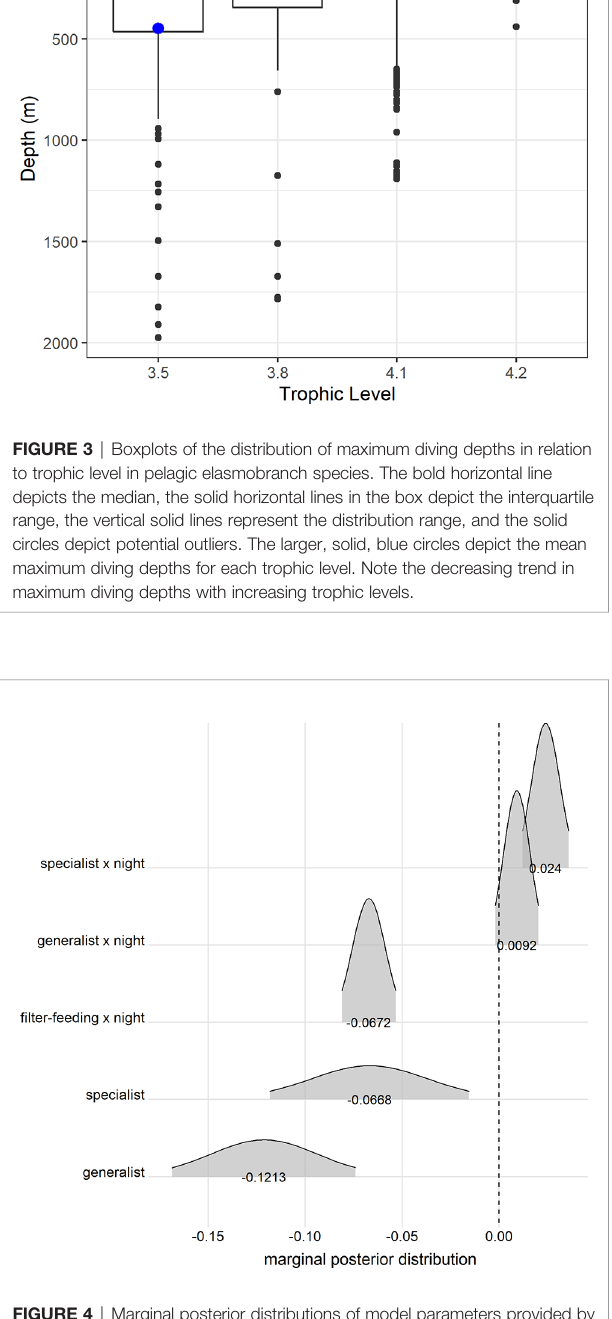
FIGURE 4 | Marginal posterior distributions of model parameters provided by a generalized linear model with integrated nested Laplace approximation developed to assess the effects of feeding habit ( fi lter-feeding, specialist, and generalist) and the interaction of feeding habit with the diel cycle (day vs. night) on pelagic elasmobranch maximum diving depths ( maxDepth ). The vertical dashed line depicts null effects. Note that 2.5% of the distribution in each tail was discarded to provide a con fi dence level of 95%.